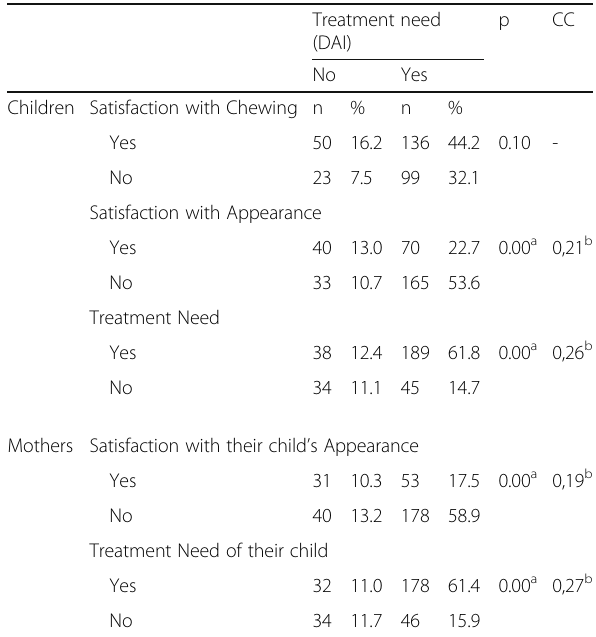
Table 3 Distribution of treatment need (DAI) and association with the satisfaction of chewing, appearance and perception of the child's treatment needs and their mothers